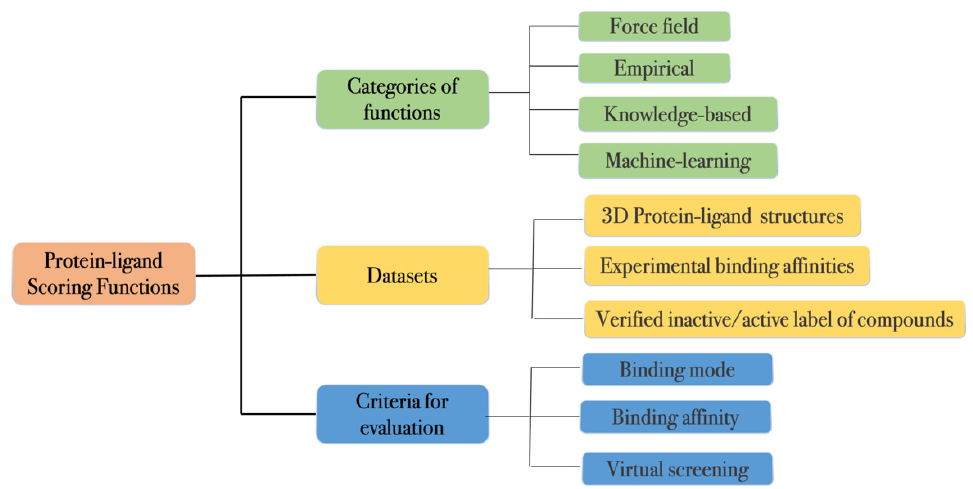
Figure 1. Schematics of the categories and datasets and evaluations of the protein–ligand scoring functions.